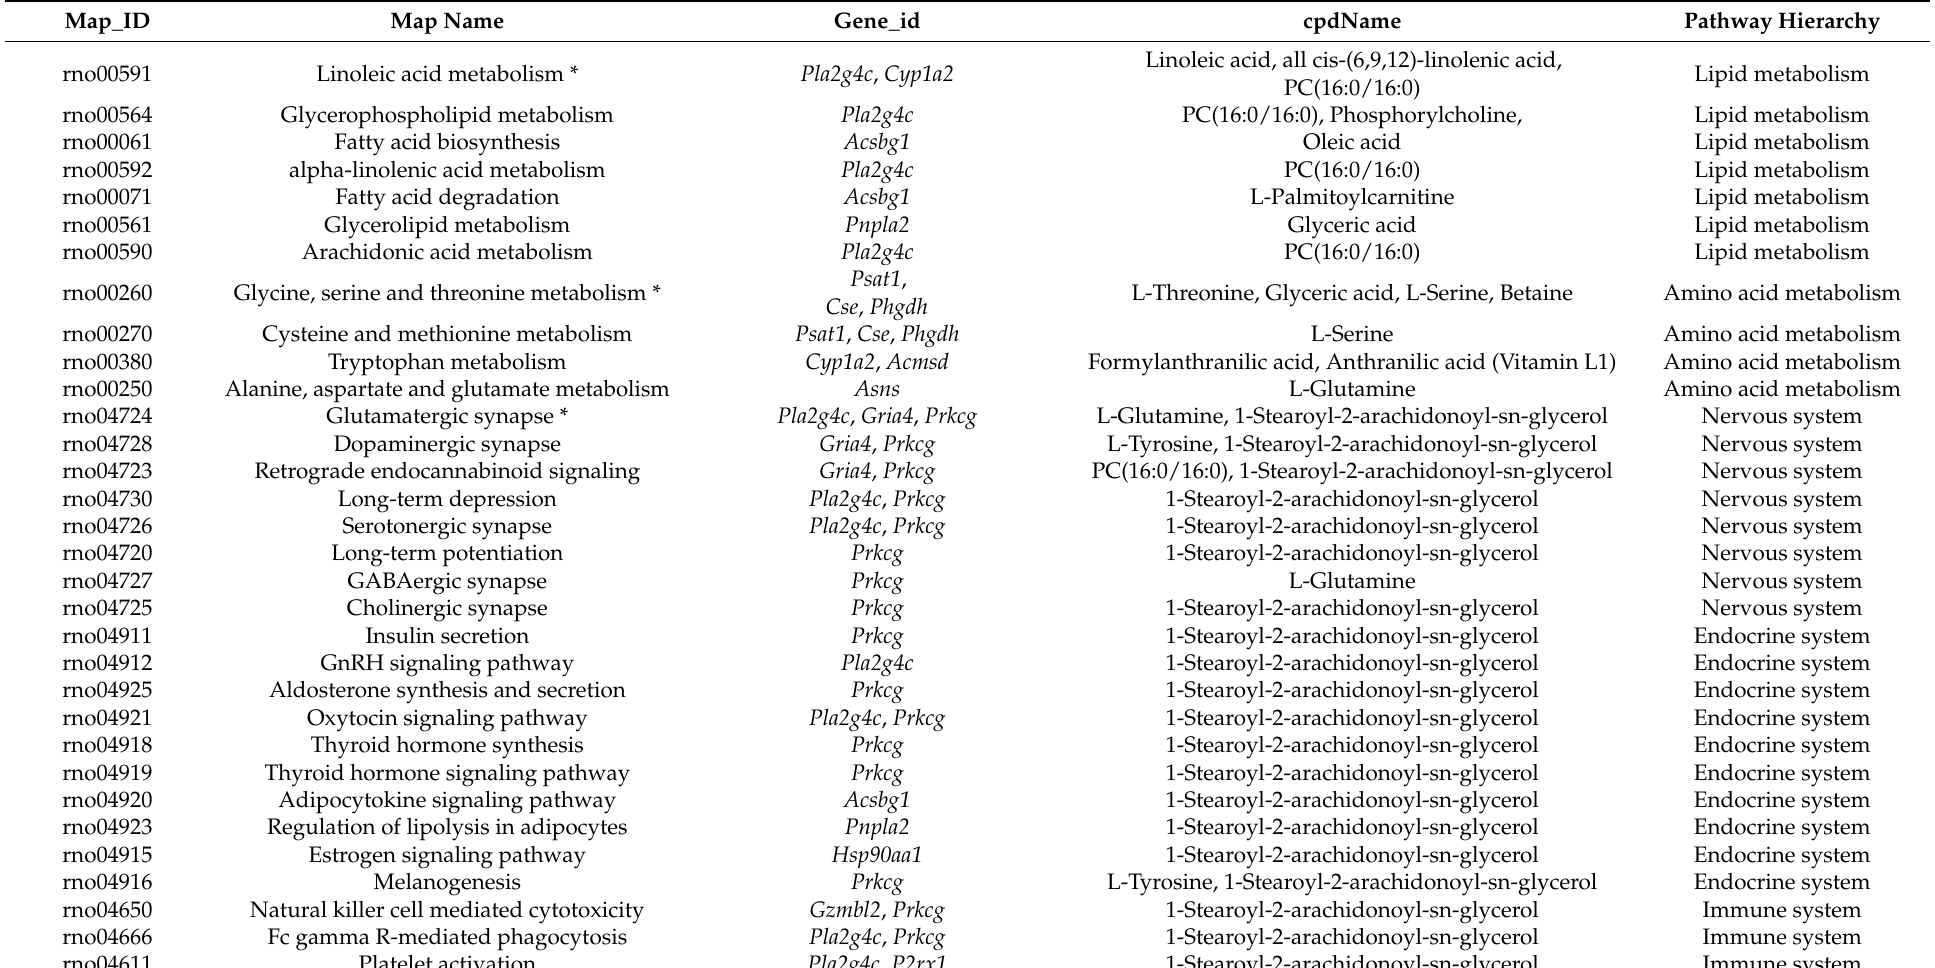
Table 1. Co-enriched